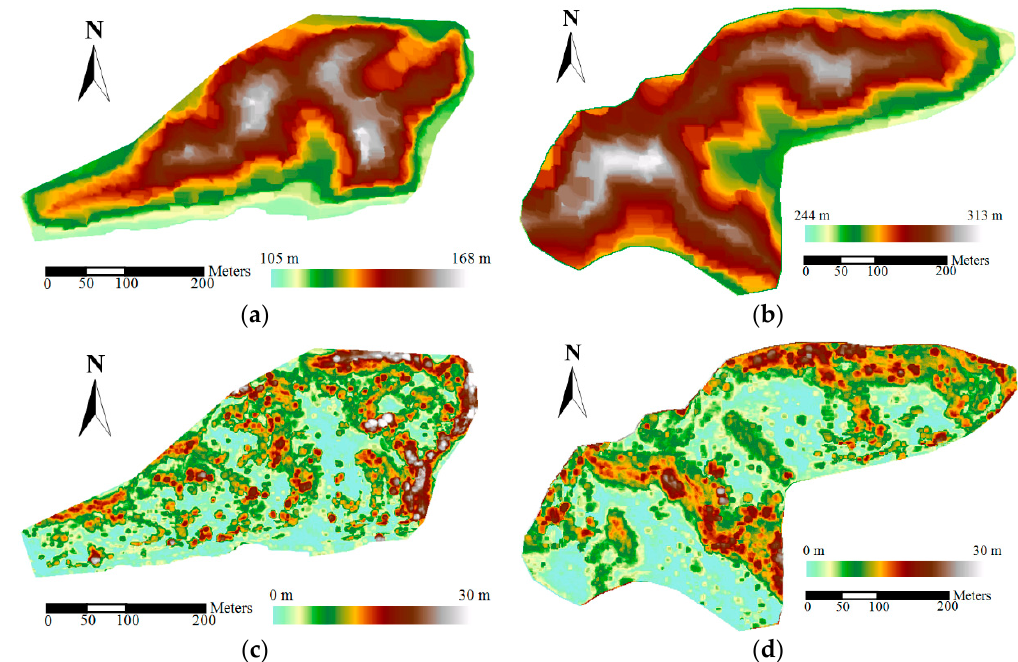
Figure 6. Example of the DoG operation and noisy point detection. DoG: difference of Gaussian.